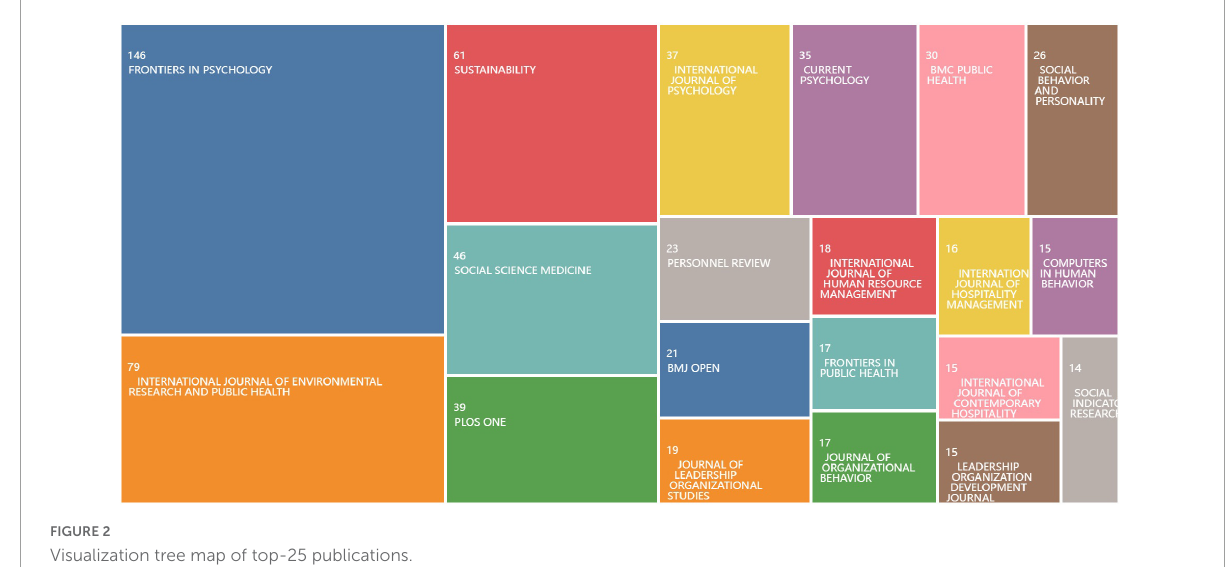
FIGURE2 Visualization tree map of top-25 publications.